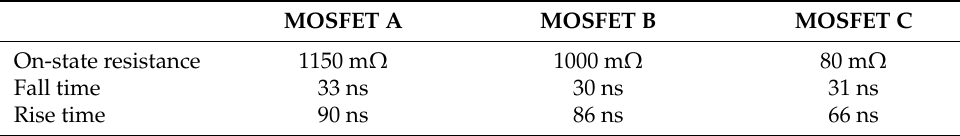
Table 1. Fall and rise times for different SiC-MOSFETs.